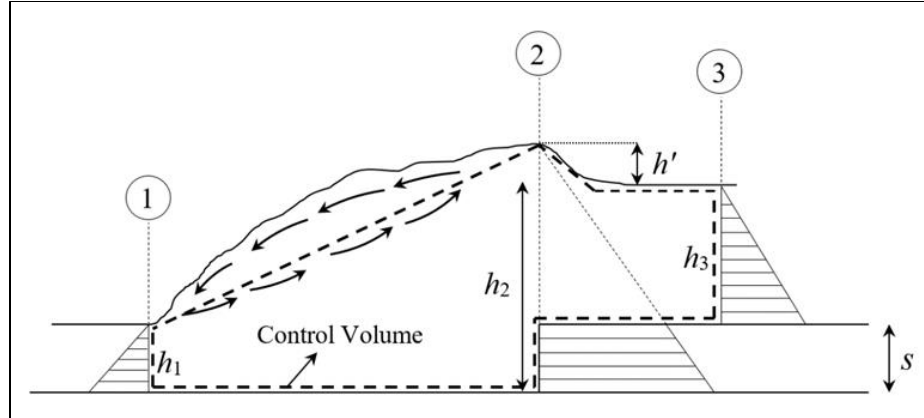
Figure 1. Sketch of an A-type hydraulic jump at a positive step.